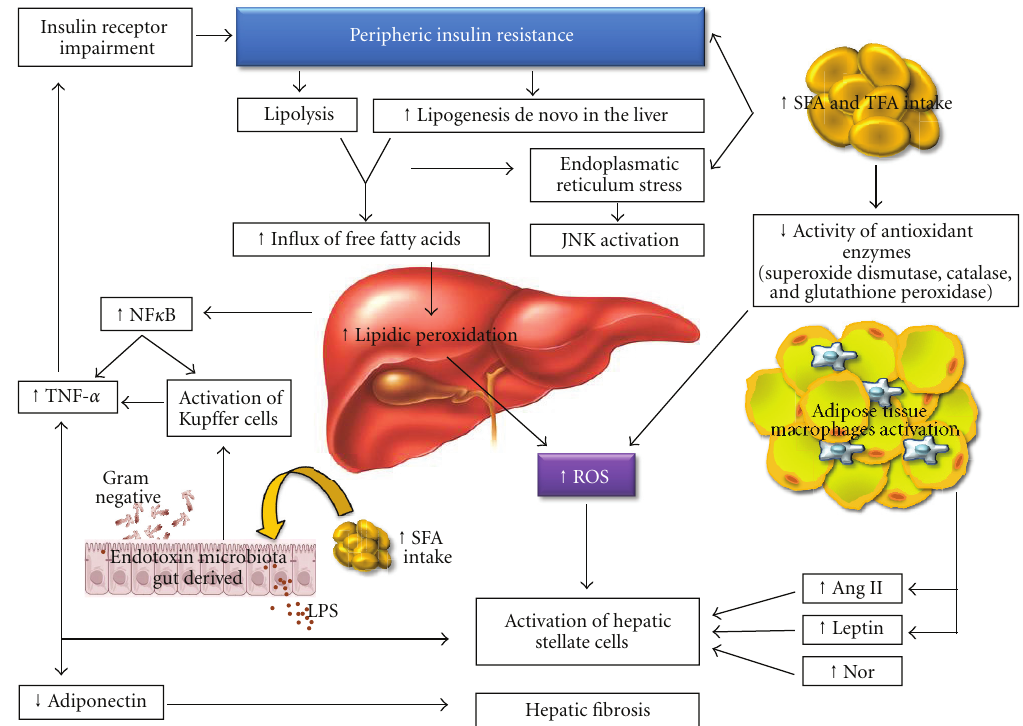
F 1: Schematic representation of SFA and TFA excess intake effects in hepatic injury and in endotoxemia. Ang II: angiotensin II, JNK: Jun N-terminal kinase, LPS: lipopolysaccharides,